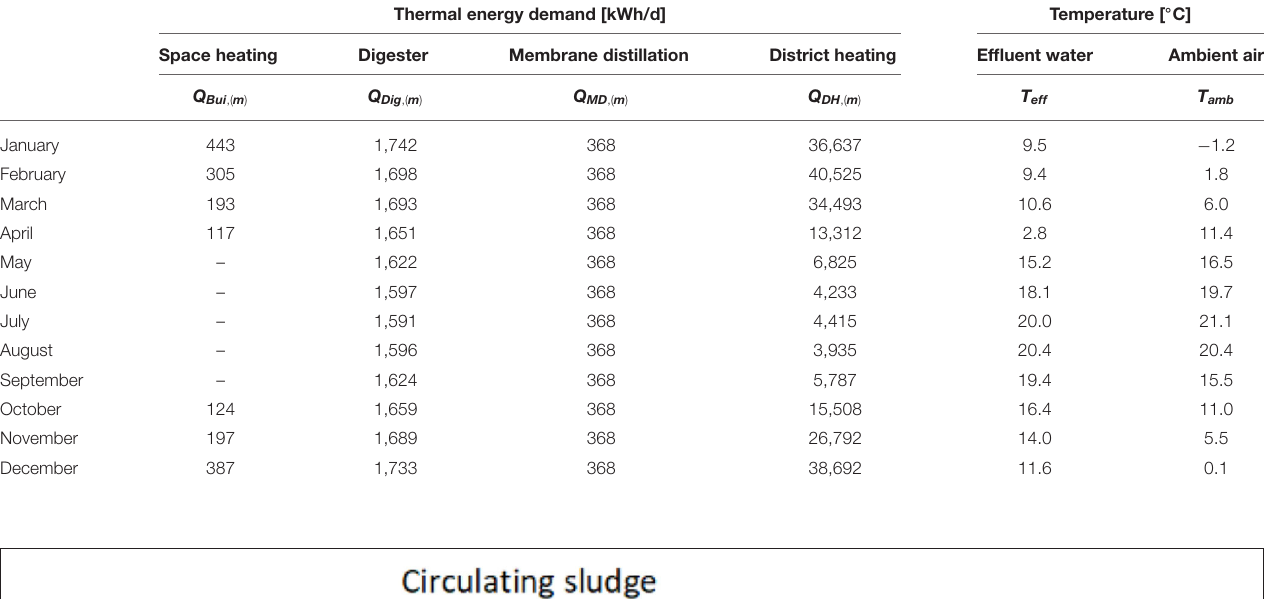
TABLE 3 | Monthly energy demands and temperatures of the case study.